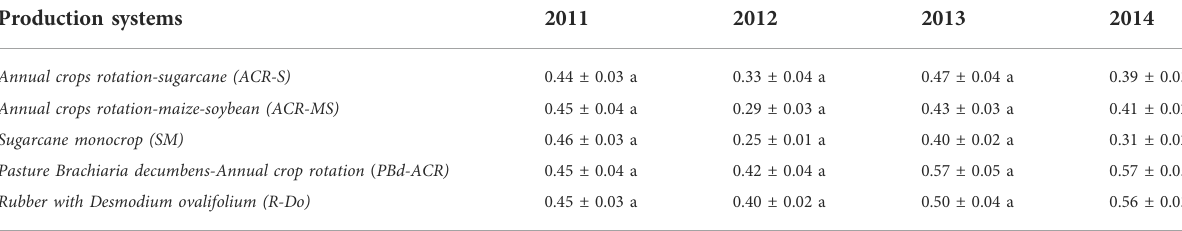
TABLE 8 Stock carbon indicator valued in the production systems established in an Oxisol of the Meta High Plains.